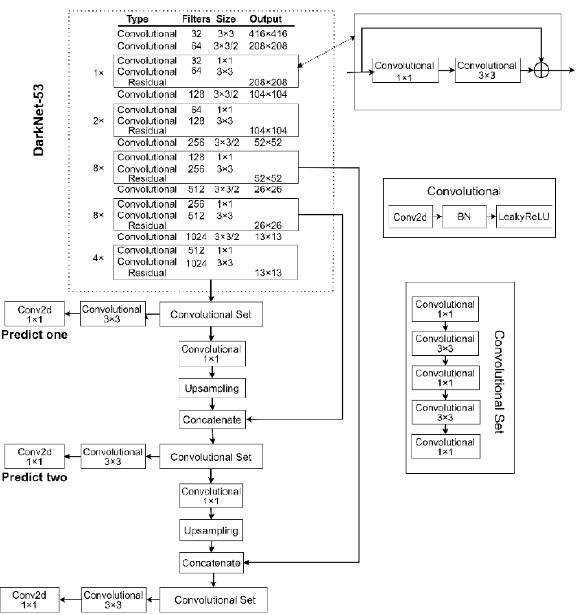
Figure 1. The network structure of YOLOv3.